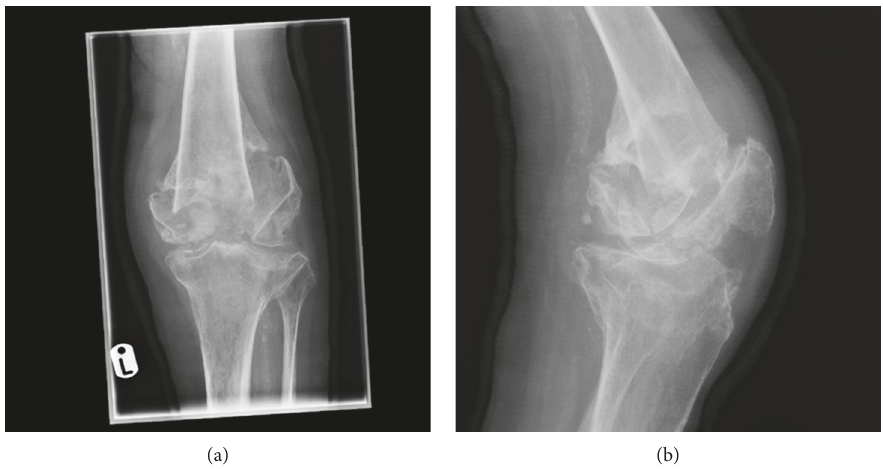
Figure 10: (a) AP and (b) lateral radiographs demonstrating ongoing nonunion and progressive